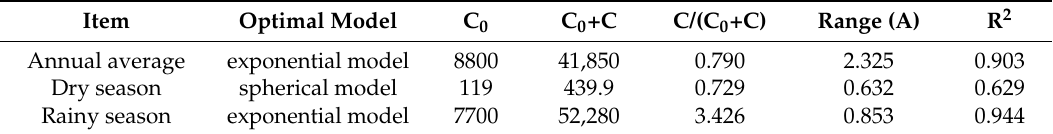
Table 9. Model parameter